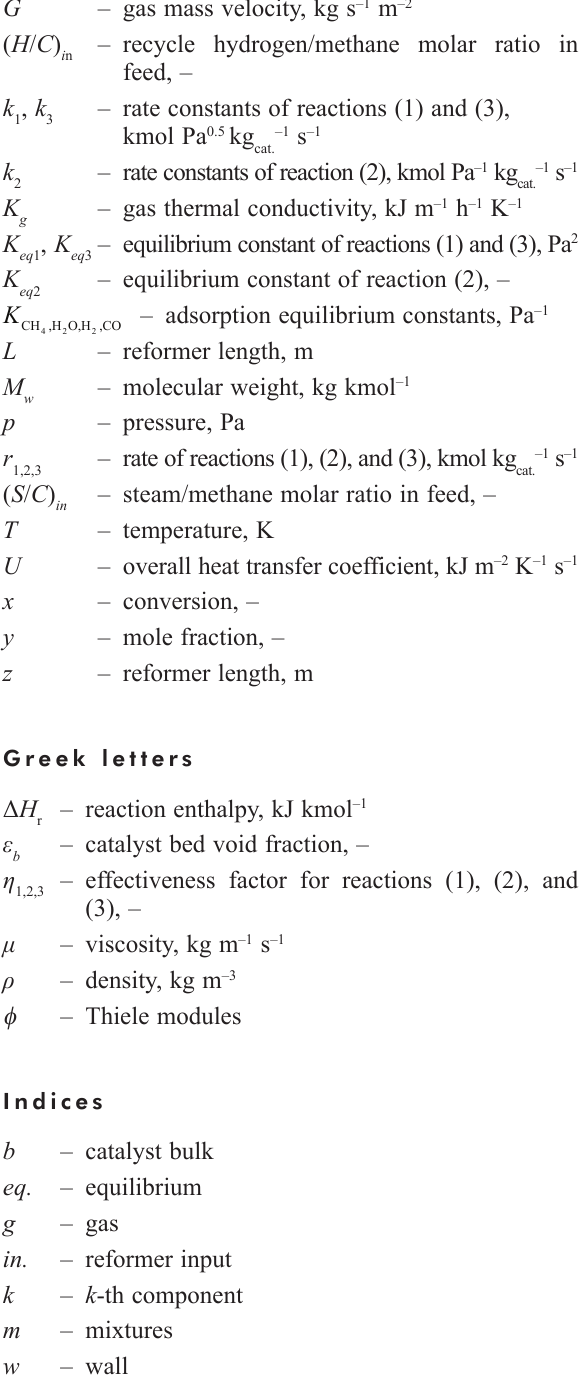
Table 5 – optimum values for decision variables